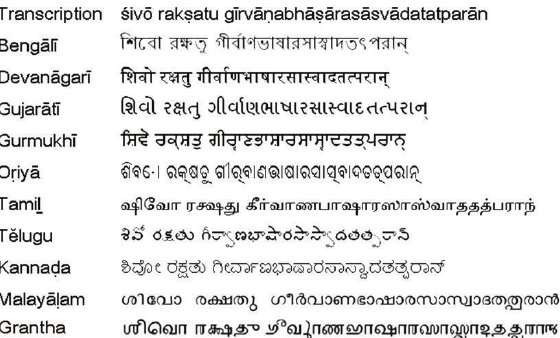
Figure 6: Samples of a few major Indian scripts (Source: http://www.myscribeweb.com/Phrase